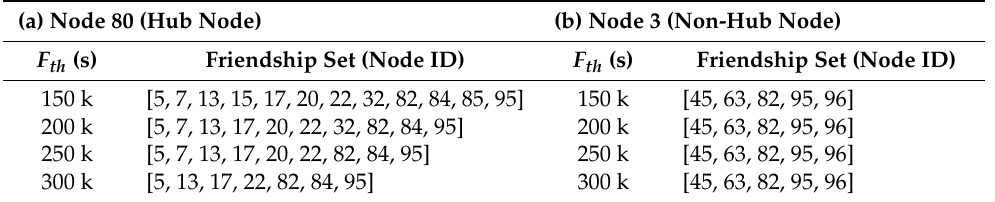
Table 1. The friendship sets of hub node and non-hub node in Reality for different values of F th . (a) Node 80 (Hub